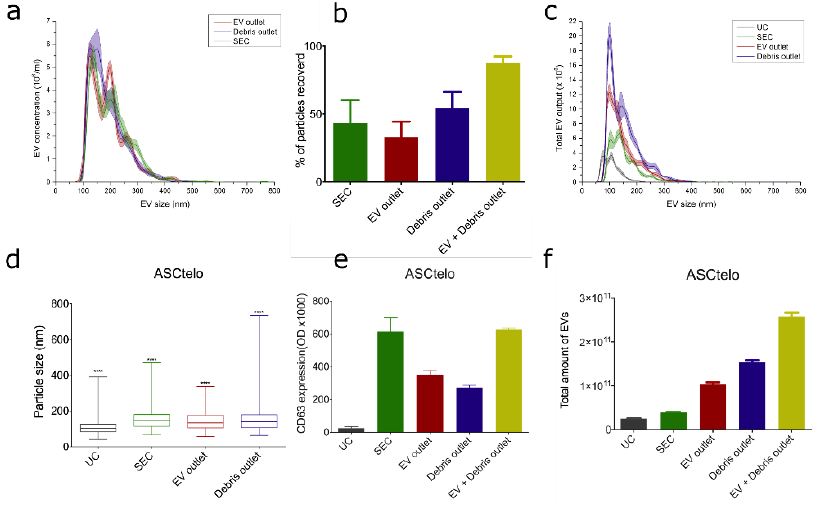
Figure 10. ( a ) Size distribution of particles per ml from EV outlet and debris outlet. Lines mean average value, while shaded area shows SD in measurements. ( b ) Percentage recovered of EV from EV spiked unconditioned bioreactor media by SEC and OSTE-COC device. Bars represent mean while whiskers SD. ( c ) Size distribution plot of total EVs isolated from ASC52-telo conditioned media by SEC, UC, EV outlet and Debris outlet of OSTE-COC device. ( d ) BoxPlot of sample size distribution obtained from ASC52telo cell media using different EV isolation techniques. **** = p < 0.0001. ( e ) CD63 ELISA expression in mean +/ − SEM. ( f ) Total number of recovered particles from ASCtelo cells media using different isolation techniques in mean +/ −